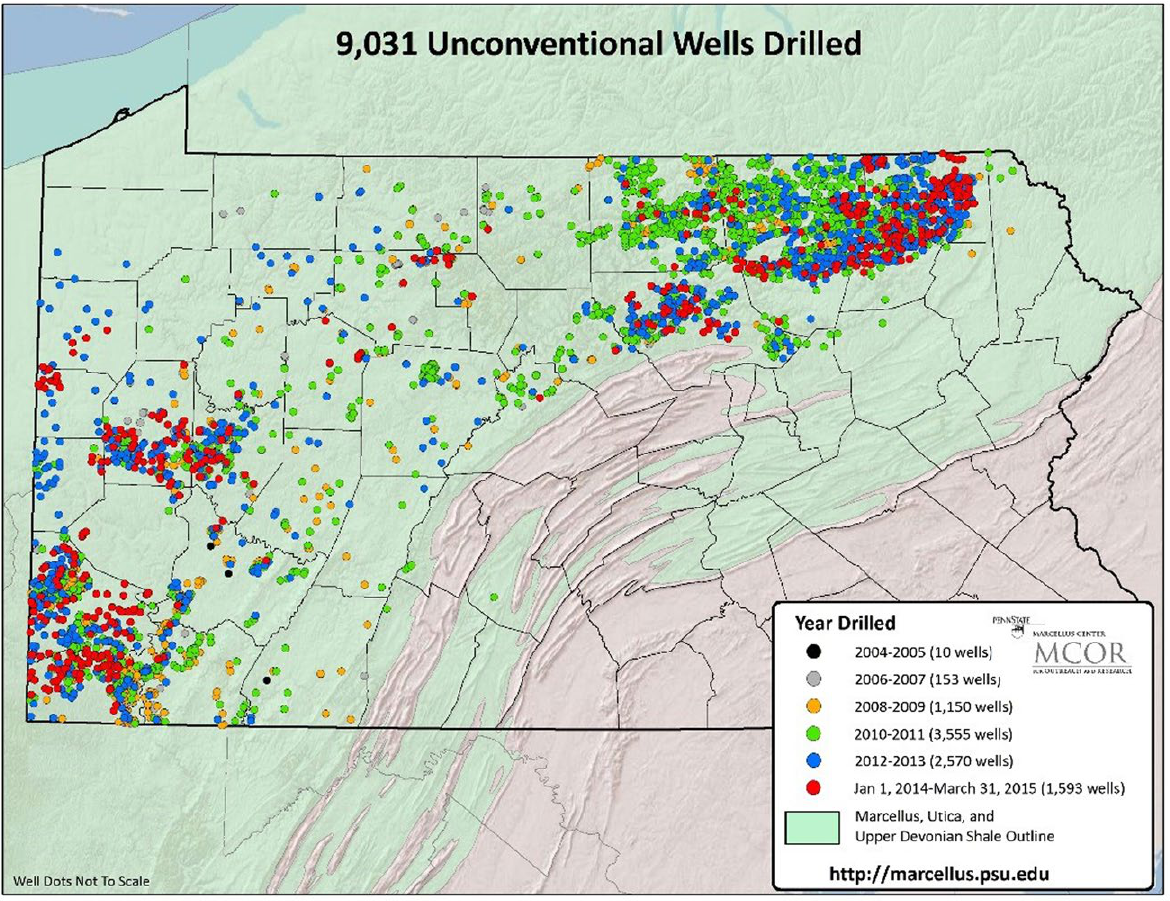
Figure 1: Map of shale gas drilling sites from 2004 to 2015. (Marcellus Center for Outreach and Research) To view the original map showing the progression of wells drilled by year, go to: http://marcellus.psu.edu/images/PA%20Ani-